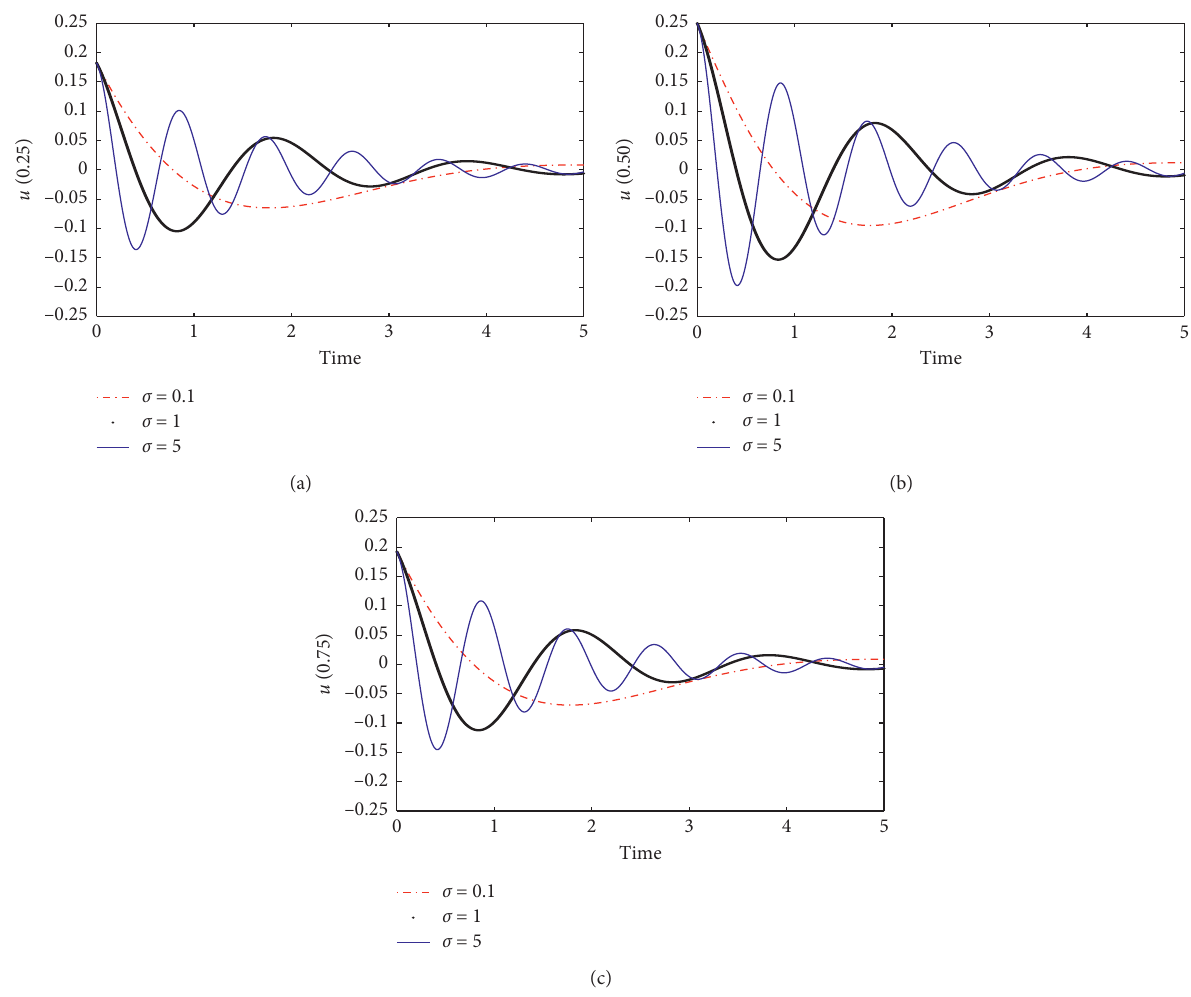
Figure 1: Test 1: damping behavior using the exponential function g